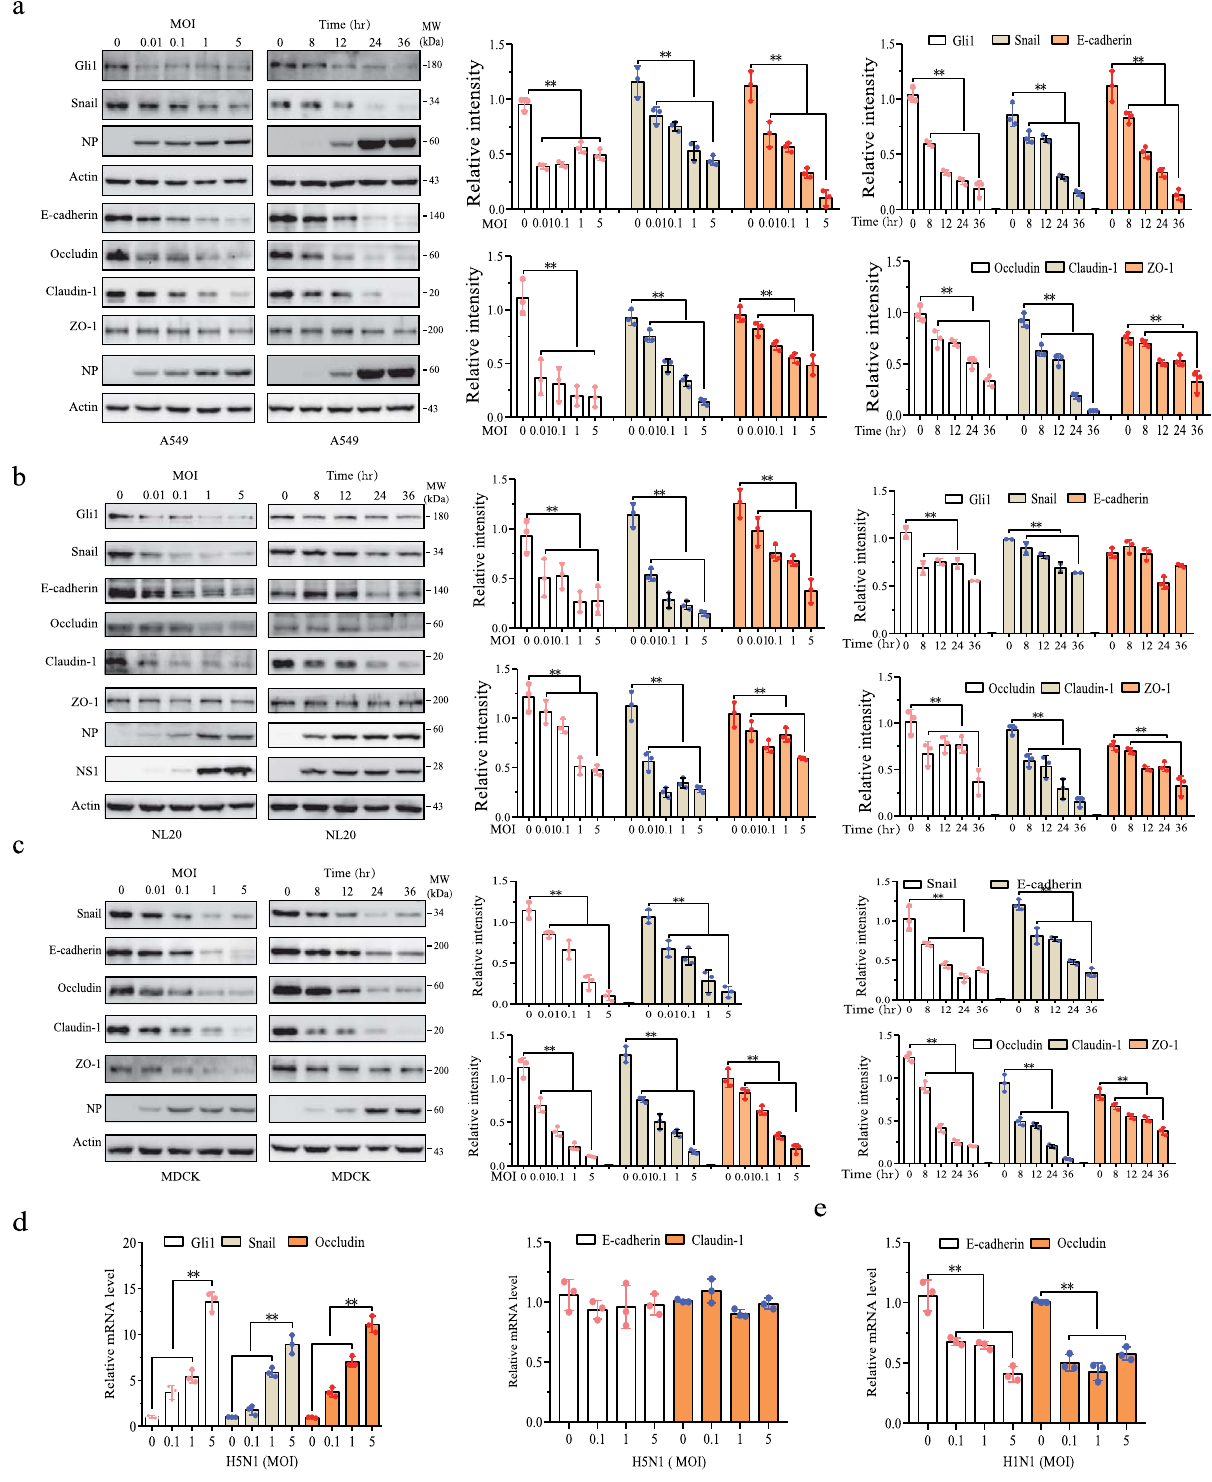
Fig. 1 The H5N1 virus down-regulates the levels of Gli1, Snail, and junction proteins. A549 ( a ), NL20 ( b ), and MDCK ( c ) cells were infected with various MOI of H5N1 viruses (the SY strain) for 24 h or with H5N1 viruses (1 MOI) for the indicated lengths of time. Cell lysates were analyzed for the levels of Gli1, Snail, and four junction proteins by Western blot. The density of the bands was analyzed by using NIH Image-J software and normalized by the arbitrary units of β -actin. Data are the mean ± SD of three experiments. *p < 0.05, **p < 0.01, com p ared to uninfected control. d , e The effect of in fl uenza viruses on GLI1 , SNAI , CDH , CLDN1, and OCLN mRNA expression. Total mRNA from A549 cells infected with the indicated MOI of H5N1 ( d ) or H1N1 ( e ) viruses was analyzed for GLI1 , SNAI , OCLN, CLDN1, and CDH mRNA levels by RT-PCR. Data are the mean ± SD of three independent experiments. **p < 0.01, compared to uninfected control. * p < 0.05, ** p <